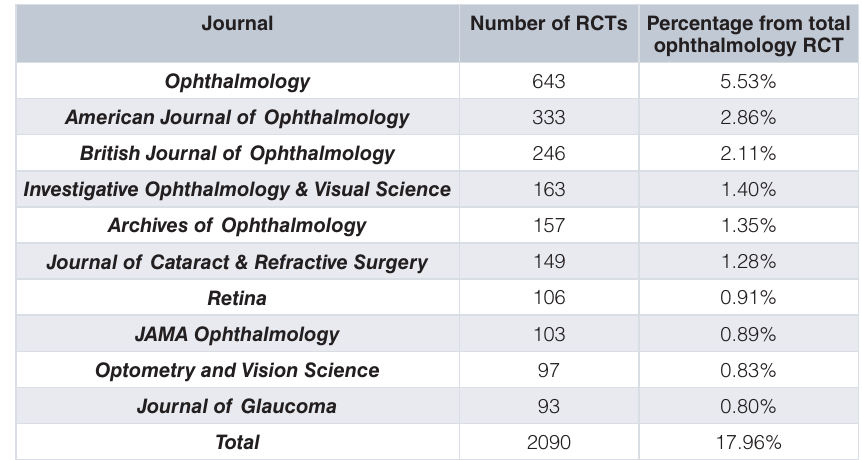
Table 2. The 10 ophthalmology journals with the highest number of randomized controlled trials (RCTs) and proportion of RCTs of total ophthalmology RCTs published in